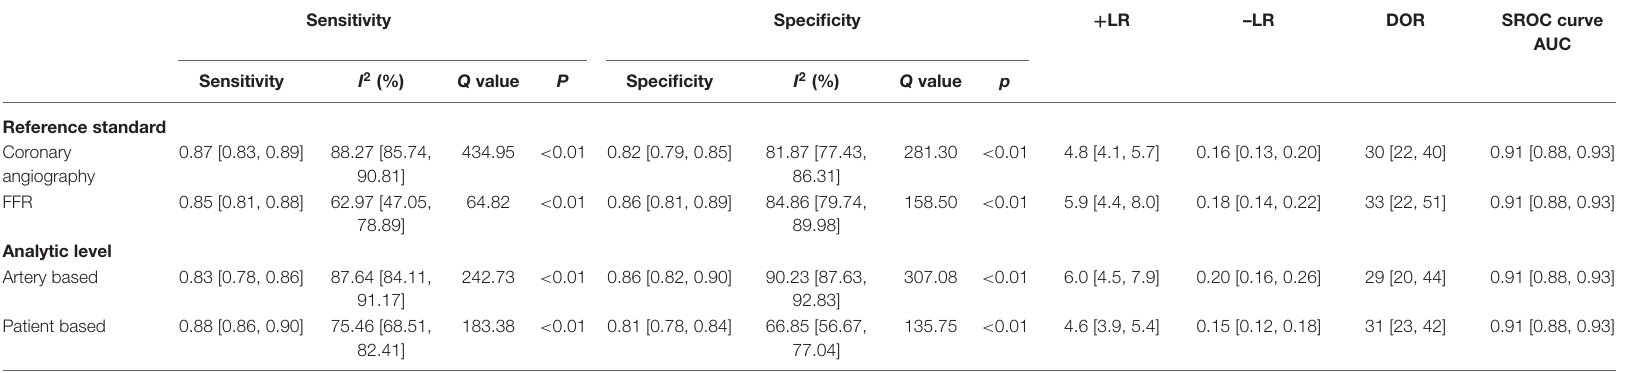
TABLE 2 | Subgroup analysis of CMR MPI.